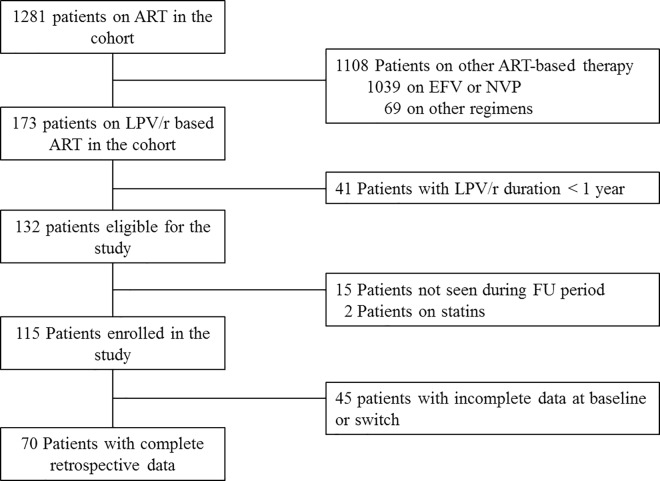
Enrolment in the study.ART: antiretroviral treatment; NNRTI: non-nucleoside reverse transcriptase inhibitors.